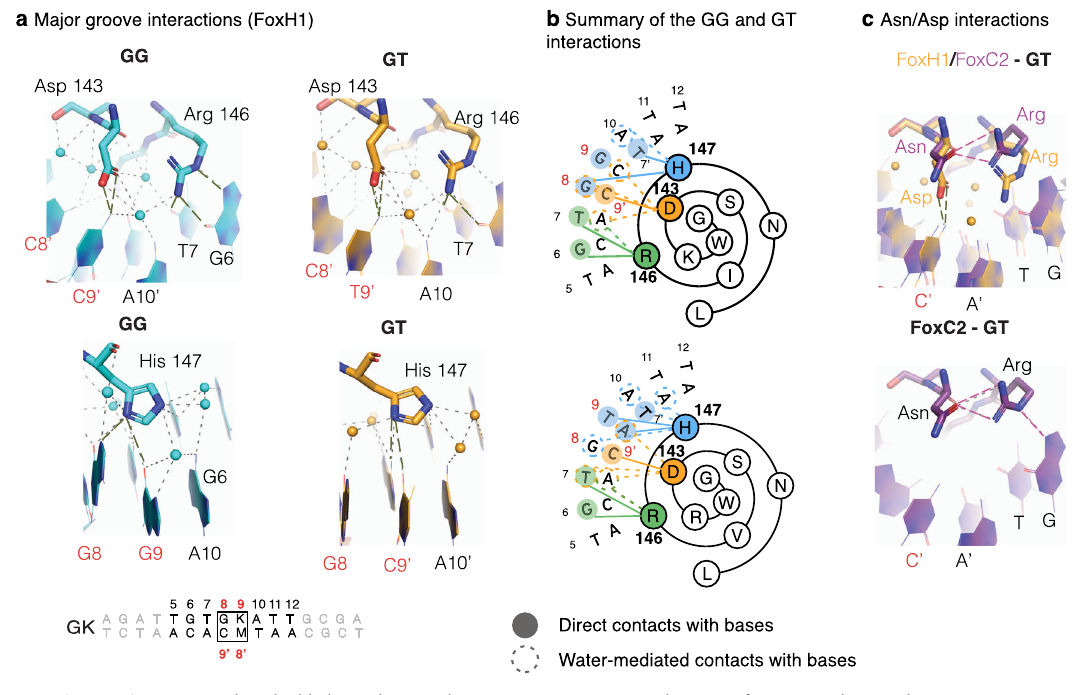
Fig. 4 | Major groove interactions. a Snapshots highlighting direct and water- mediated polar contacts from the Asp143, Arg146 and His147, located in H3, with nucleobases (distance up to 3.6Å) of the major groove. Contacts of Asp and Arg with the DNA in the GG and GT complexes are similar. The main differences con- centratedattheHisresidue,whichbindstotheGorTsites.IntheGGcomplex,the Asp residue is found in double conformations, with the main conformation (75% occupancy)correspondingtothatseenintheGTcomplex.Intheotherorientation, the side chain is rotated approximately 90 degrees. For clarity, we show only the